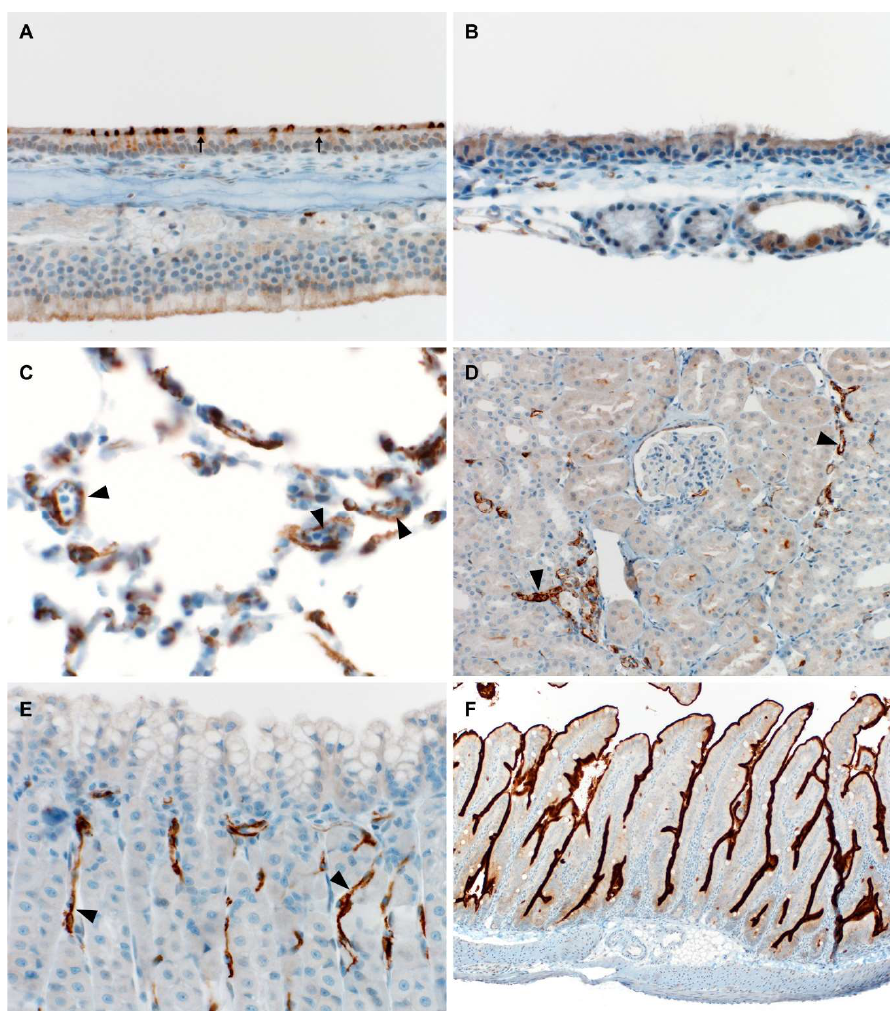
Figure 2. ACE2 immunohistochemistry of ( A ) nasal turbinate—400 × , multifocal apical immunoreactivity in ciliated epithelial cells (arrows); ( B ) trachea—400 × , negative immunostaining; ( C ) lung—400 × , multifocal cytoplasmic endothelial cell immunoreactivity (arrowheads): ( D ) kidney—200 × , multifocal cytoplasmic endothelial cell immunoreactivity (arrowheads); ( E ) stomach—400 × , multifocal cytoplasmic endothelial cell immunoreactivity (arrowheads): ( F ) intestine—100 × , diffuse immunoreactivity of brush